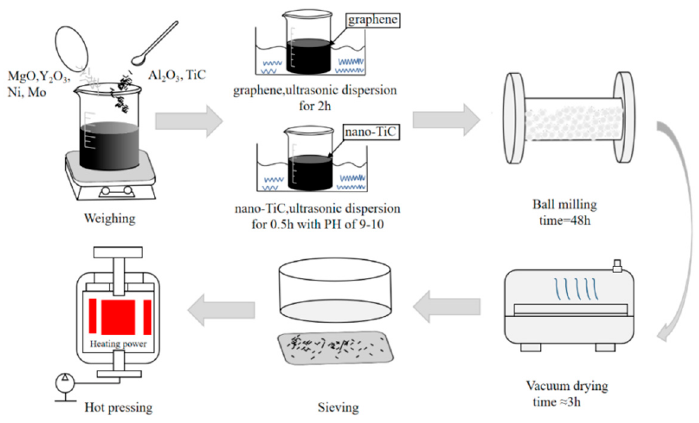
Figure 2. Brief experimental procedure of the composites.